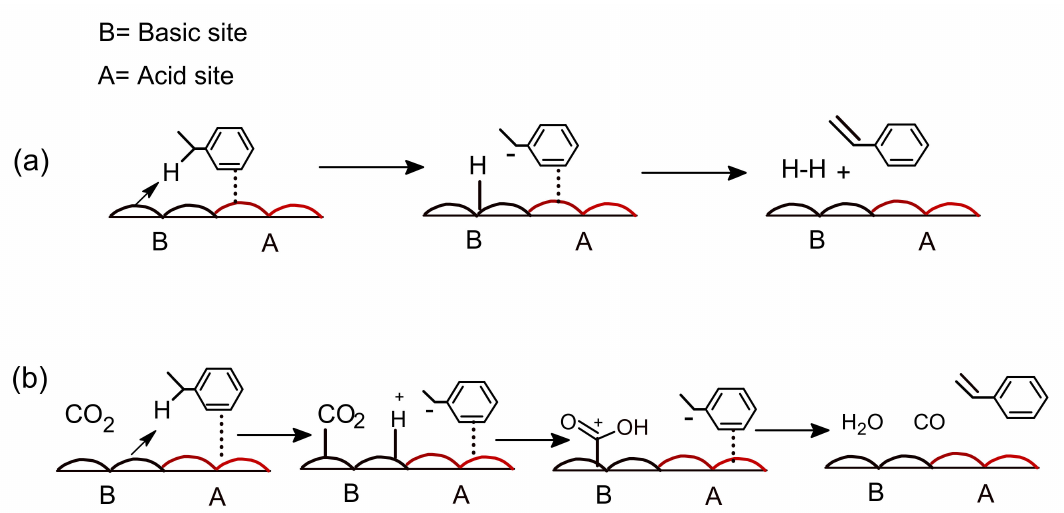
Figure 4. The procedure of oxidative dehydrogenation of ethylbenzene to styrene ( a ) without CO 2 and